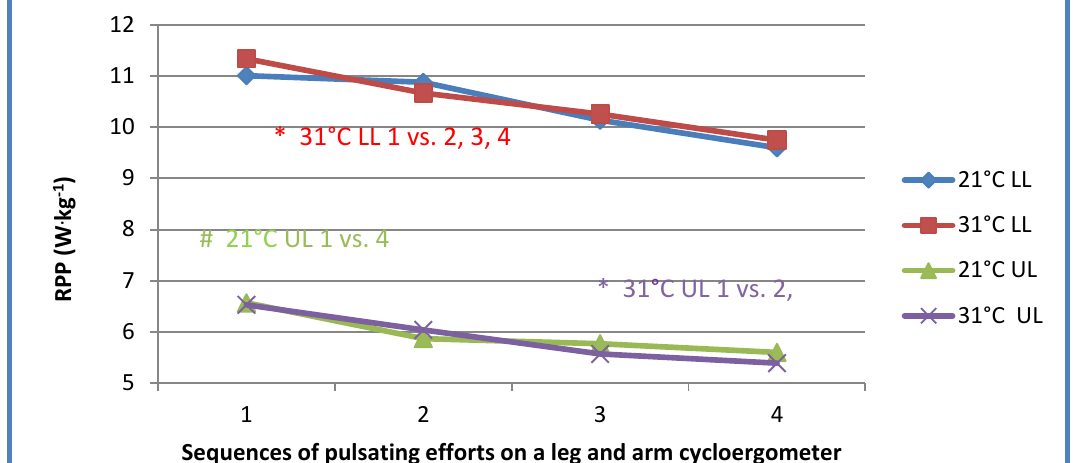
Figure 3. Relative peak power (RPP) values in the second of 5 series of physical exercises performed by the lower (LL) and upper limbs (UL) at ambient temperatures of 21 °C and 31 °C. # — significant differences at p < 0.05, 21 °C: differences between individual measurements; * — significant differences at p < 0.05, 31 °C: differences between individual measurements.